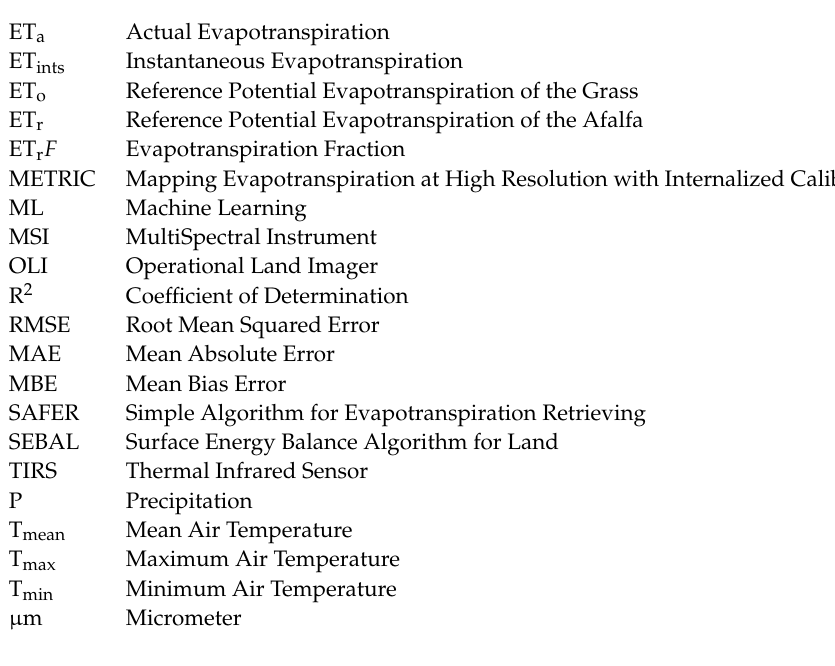
approach 1 algorithm; Figure S2: Importance of the variables for the approach 1 Cubist algorithm; Figure S3: Importance of the variables for the approach 1 XgbLinear algorithm; Figure S4: Importance of the variables for the approach 1 XgbTree algorithm; Figure S5: Importance of the variables for the approach 2 LM algorithm; Figure S6: Importance of the variables for the approach 2 Cubist algorithm; Figure S7: Importance of the variables for the approach 2 XgbLinear algorithm; Figure S8: Importance of the variables for the approach 2 XgbTree